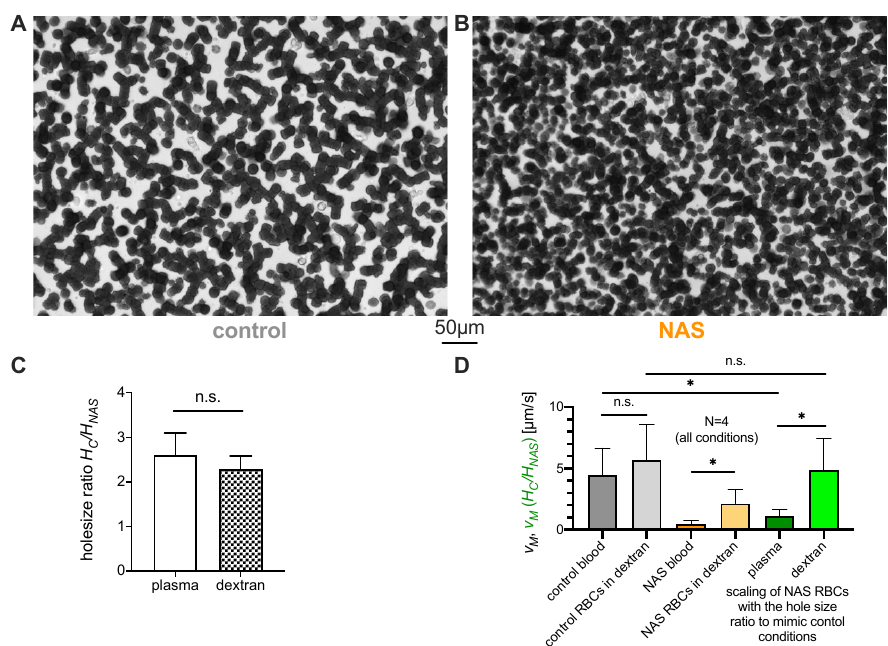
Figure 4. Characteristics of sedimenting erythrocyte aggregates in various suspension media. ( A , B ): Sedimented layer of erythrocytes in 55 mg/mL dextran from ( A ): a healthy control donor and ( B ): a NAS patient (MLS-3). The characteristic area of the holes in the network is visibly smaller in the network of the NAS patient’s erythrocytes. As a replacement medium, we used 70 kDa dextran diluted in PBS to a final mass concentration of 55 mg/mL. ( C ): The measured ratio of mean hole size for the suspension media (autologous plasma and dextran diluted in PBS with a mass concentration of 55 mg/mL). The dextran concentration was empirically chosen in order to achieve a sedimentation speed as close as possible to the rate obtained in the plasma of the healthy samples. ( D ): Characteristic (maximal) erythrocyte sedimentation velocities, with scaling based on aggregate geometries. The bars indicate the values of the characteristic erythrocyte sedimentation velocities. For each suspension medium, the patient scaling was obtained by multiplying the characteristic speed of each patient’s erythrocytes by the ratio of the characteristic hole areas, as justified by Equation (3). While the scaled velocity in autologous plasma is significantly smaller than the characteristic speed of the control erythrocytes, the scaling lies within the same range when the autologous plasma is replaced by a dextran-based medium. n.s., not significant ( p > 0.05); * p <